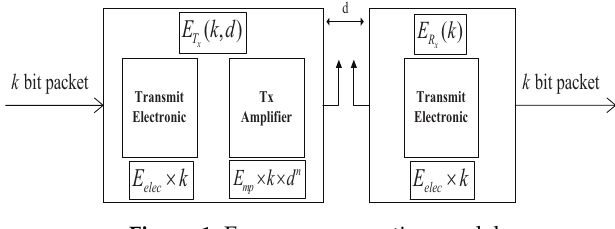
Figure 1. Energy consumption